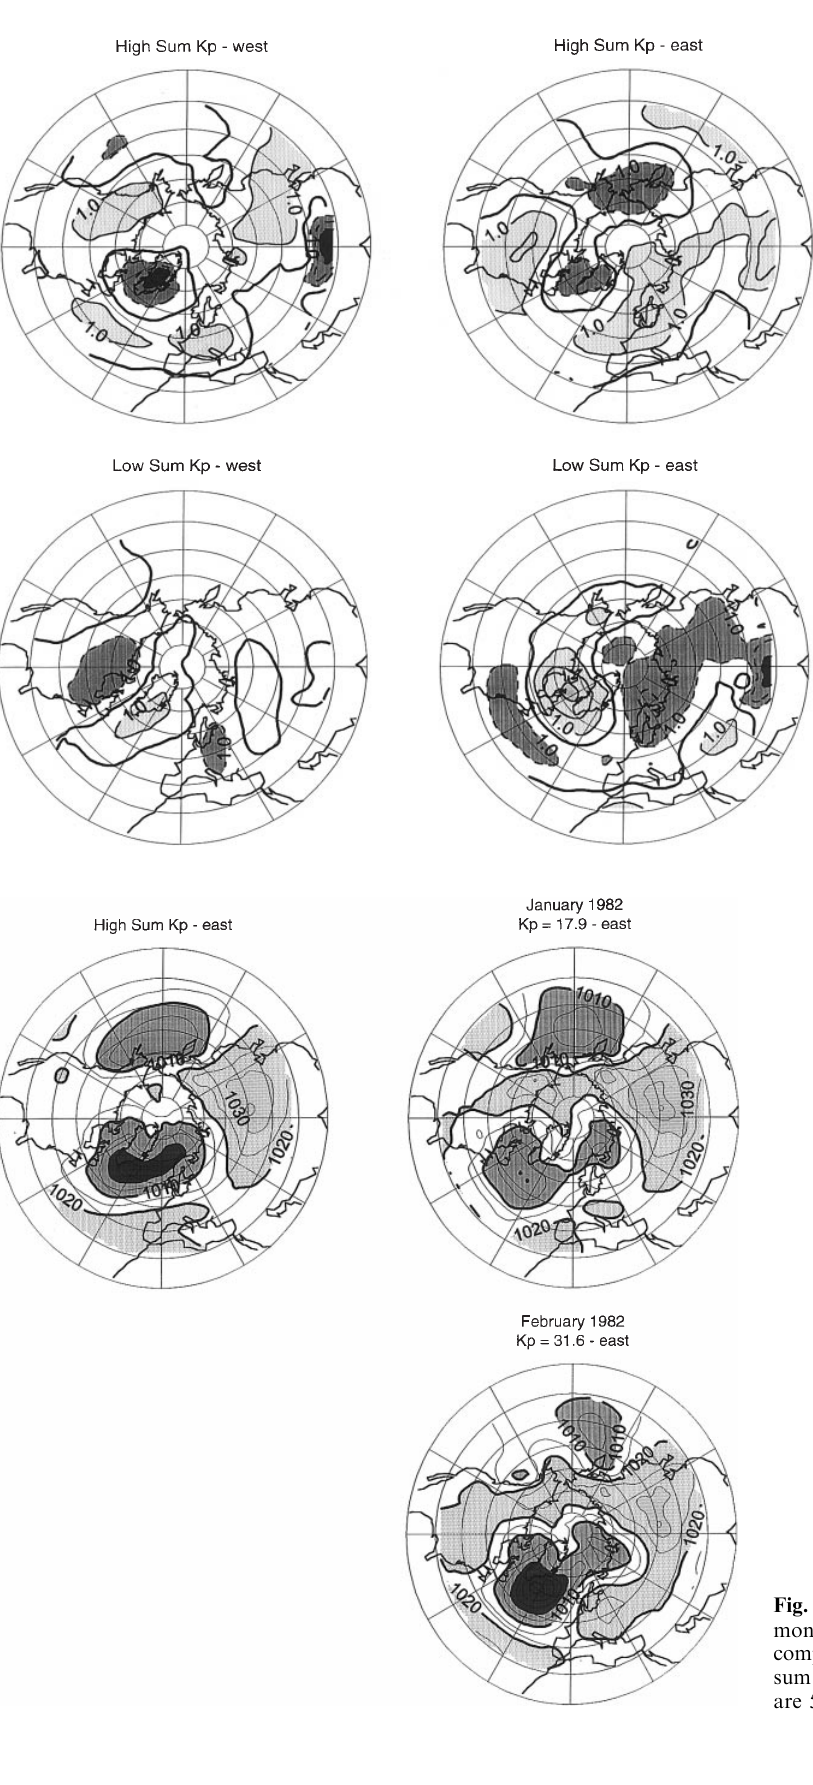
Fig. 4. Dominant pressure system in individual months of winter period 1982 in comparison with the composite map of dominant pressure system at high sum Kp, QBO-east. The intervals between contours are